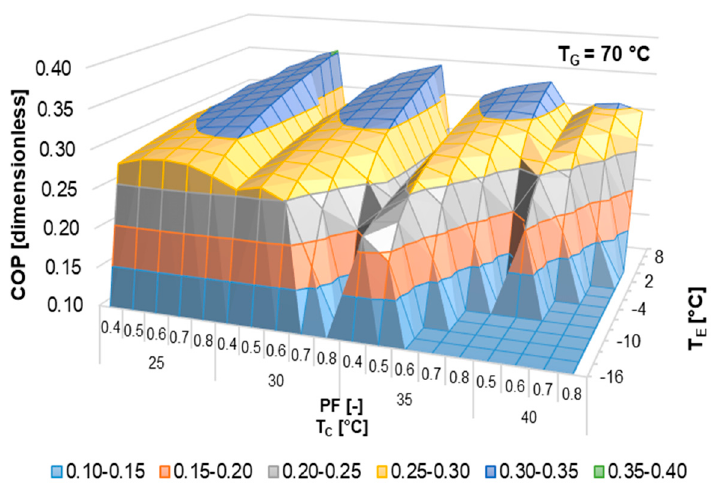
Figure 10. Coefficient of performance (COP) of the half-effect cycle against PF and T E for different T C . Analyzed case: T G = 70 °C.